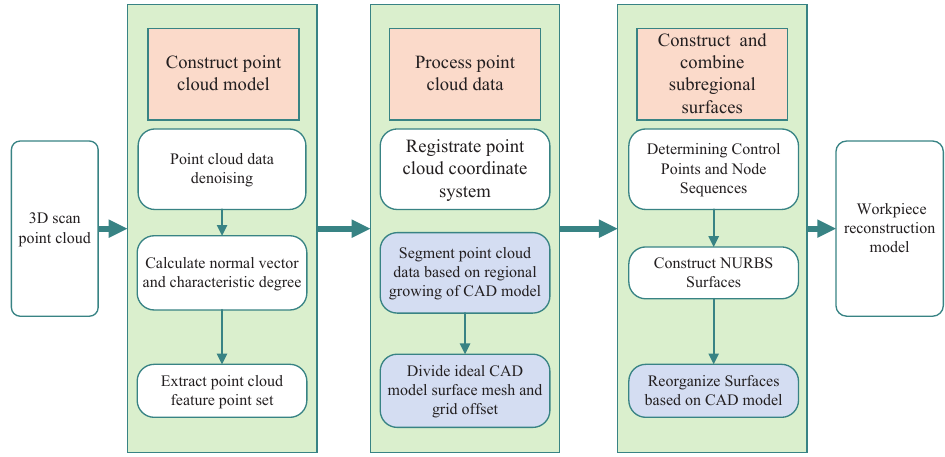
Figure 1. The flow chart of reverse engineering method based on prior CAD